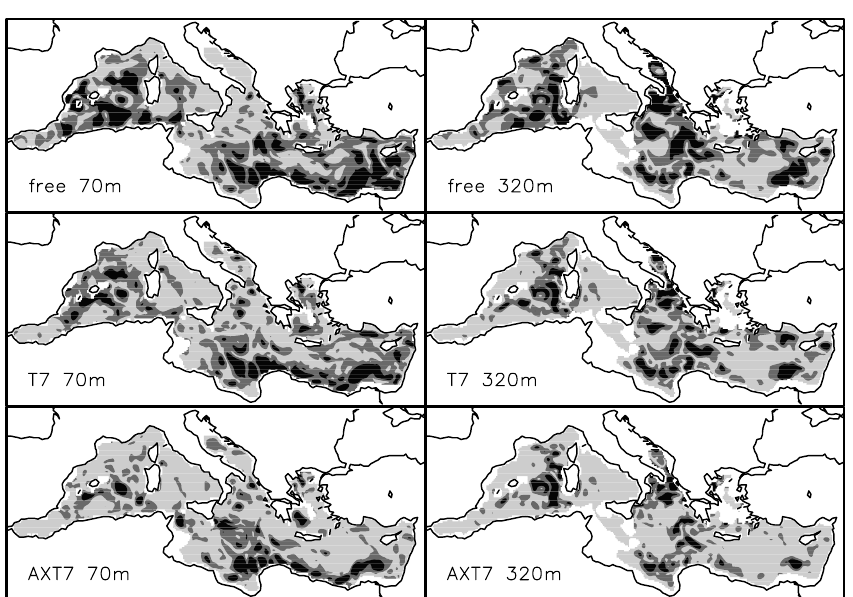
Fig. 9. Time-averaged (days 21–84) error in the summer OSSEs for se- lected sampling strategies and depths. Light grey corresponds to errors less than 0.5 ◦ C at 70m depth and 0.1 ◦ C at 320m; black corresponds to errors greater than 1.0 ◦ C at 70m depth and 0.2 ◦ C at